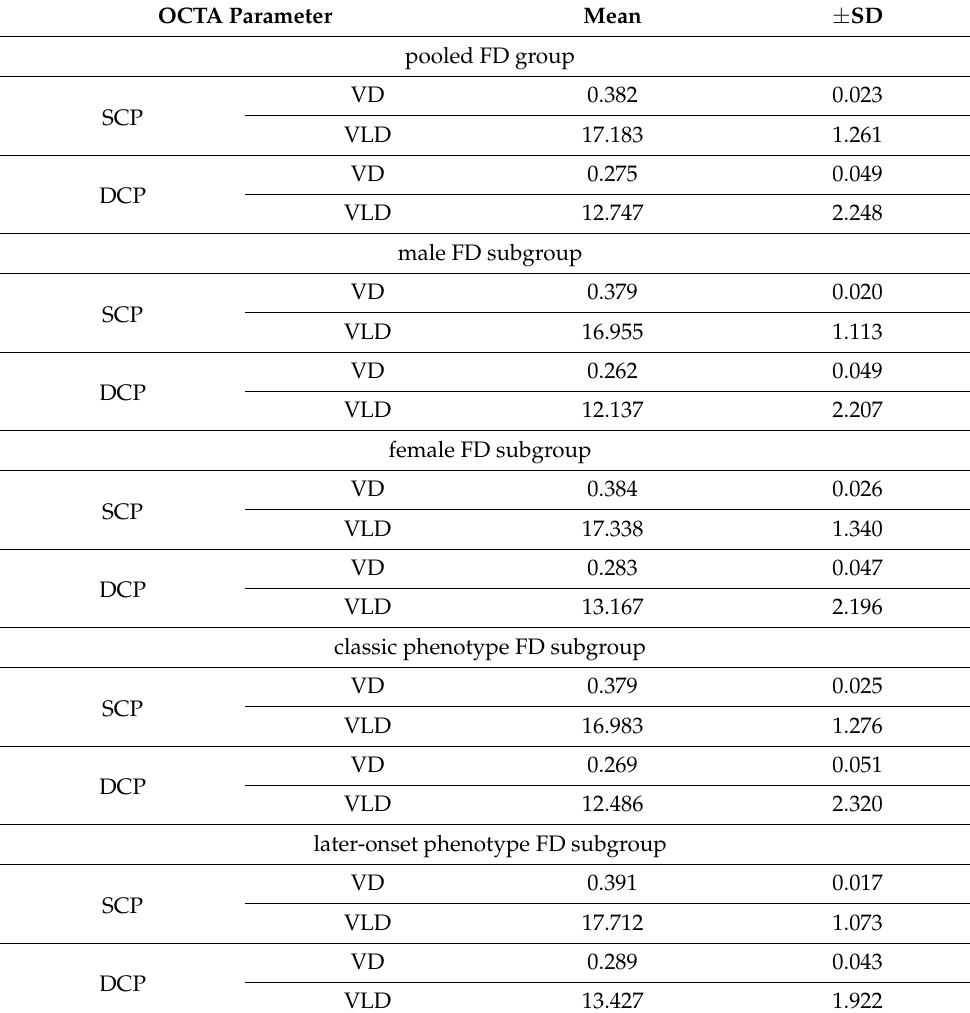
Table 4. Mean values of OCTA